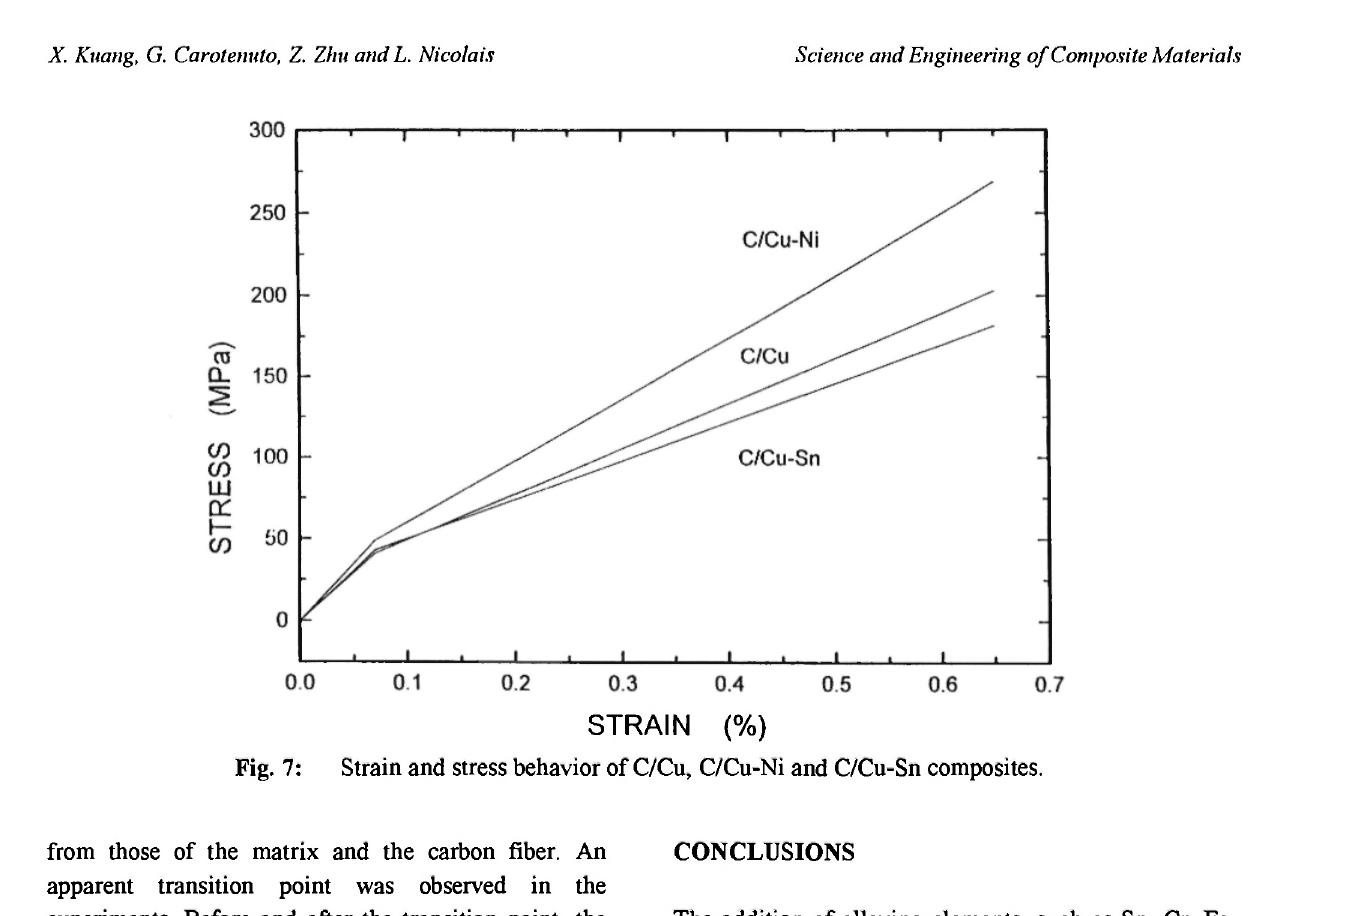
Fig. 7: Strain and stress behavior of C/Cu, C/Cu-Ni and C/Cu-Sn